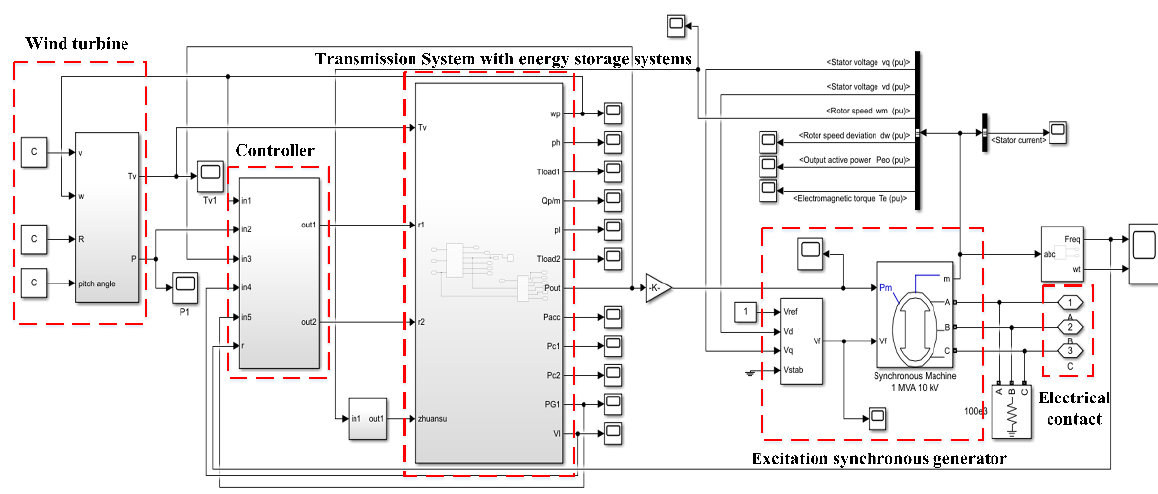
Figure 11. Simulation model of the energy storage hydraulic wind turbine. In the power system module simulation, a single-area two-unit power system simulation model is built, as shown in Figure 12.